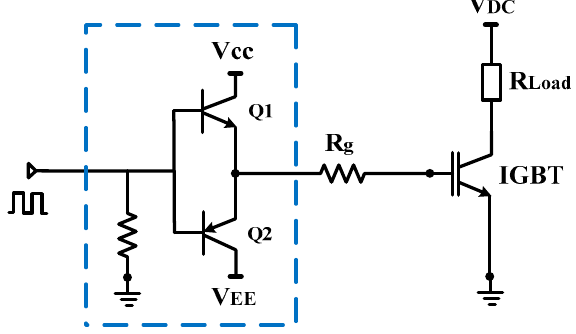
Figure A2. Totem-pole interface unit to gate current supply.